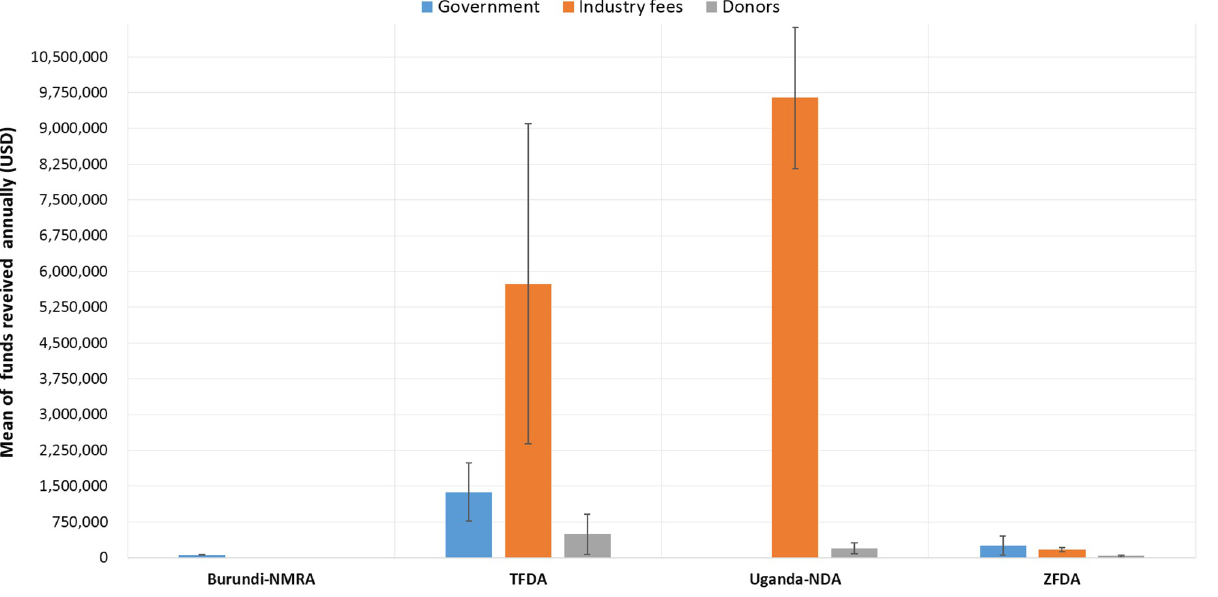
Fig 3. Annual mean amounts and sources of funds received by National medicines regulatory